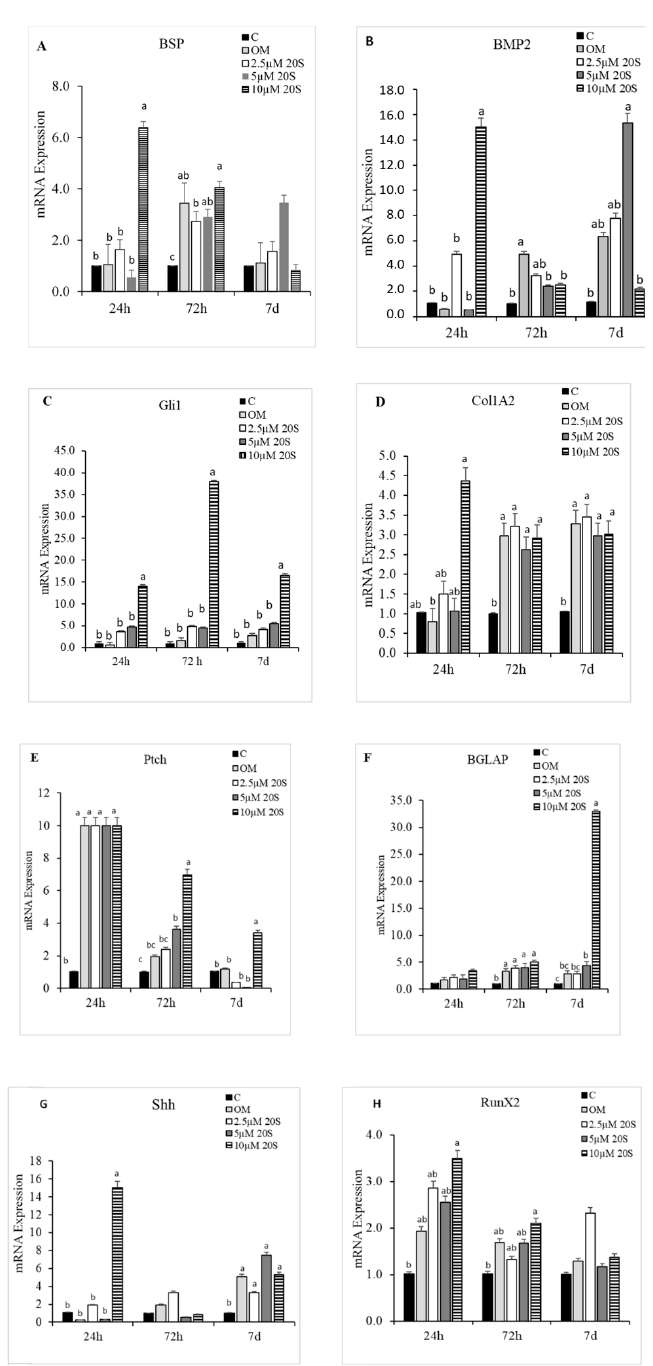
Figure 3. Osteogenic e ff ects of 20S oxysterol in mesenchymal stem cells. Relative levels of mRNA expression of osteogenic genes ( A ) BSP, ( B ) BMP2, ( C ) Gli-1, ( D ) Col1A2, ( E ) Ptch, ( F ) BGLAP, ( G ) Shh, and ( H ) RunX2 in chicken compact bone-derived mesenchymal stem cells (cBMSCs) treated with di ff erent levels of oxysterol. cBMSCs were treated with (1) Control (C), (2) osteogenic media (OM) containing DMEM with 10% FBS, 50 µ g / mL ascorbate, 0.5 µ M DXA, and 10 mM β -glycerophosphate, (3) OM + 2.5 µ M 20S, (4) OM + 5 µ M 20S, or (5) OM + 10 µ M 20S. Cells were harvested at 24 h, 72 h, and 7 d after treatment. RNA was isolated, reverse transcribed to cDNA, and qRT-PCR was conducted to analyze osteogenic gene expression. GAPDH was used as a housekeeping gene. Fold changes in gene expression relative to the control were calculated using the − ∆∆ Ct method. Bars represent mean ± SEM for triplicate determinations. Within each harvested period, bars without a letter (a–b) in common are significantly di ff erent ( p < 0.05) when analyzed with Tukey’s